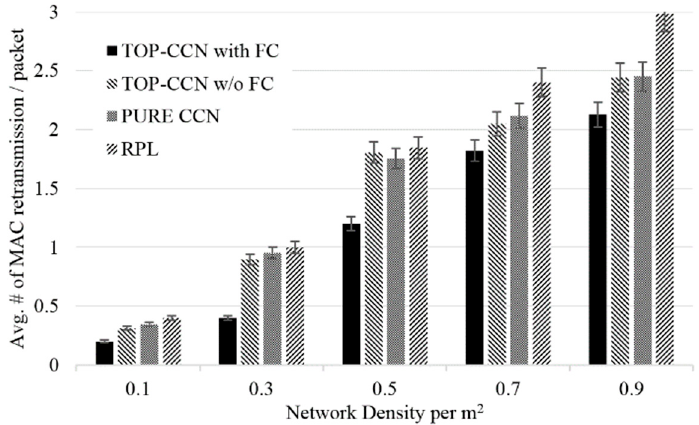
Figure 10. Average MAC retransmission per packet.